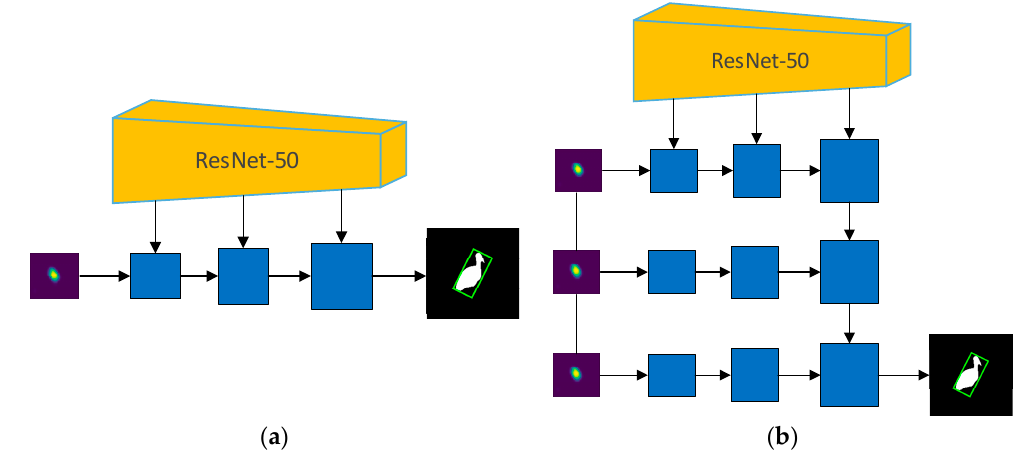
Figure 8. ( a ) Single-stage refinement pathway; ( b ) multi-stage refinement pathway. Table 6. Results of ablation study on VOT2016 dataset. Red and blue represent 1st and 2nd, respec- tively. EAO ↑ Accuracy ↑ Robustness ↓